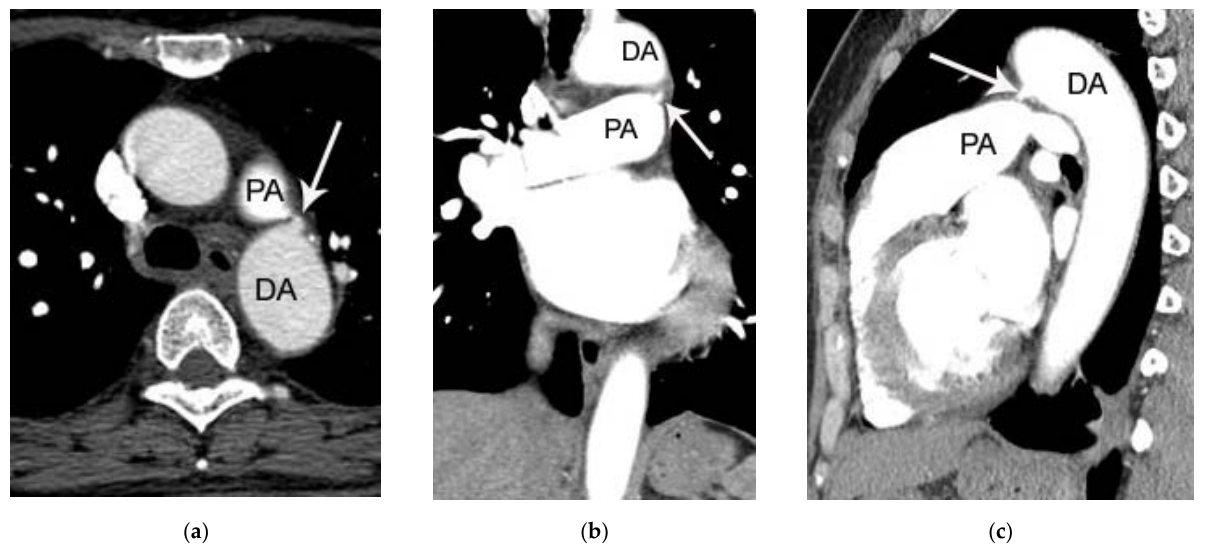
Figure 3. Another case of PDA in a 52 ‐ year ‐ old female patient (group 2) missed on both initial chest CT report and by the two blind readers. On axial ( a ), coronal ( b ), and sagittal ( c ) post ‐ contrast chest CT image, a small protruding structure (arrow) connecting the left main pulmonary artery (PA) and descending thoracic aorta (DA) is noted. Because of the small size of PDA (only 3 mm), it may be easily missed on chest CT in the absence of careful inspection.